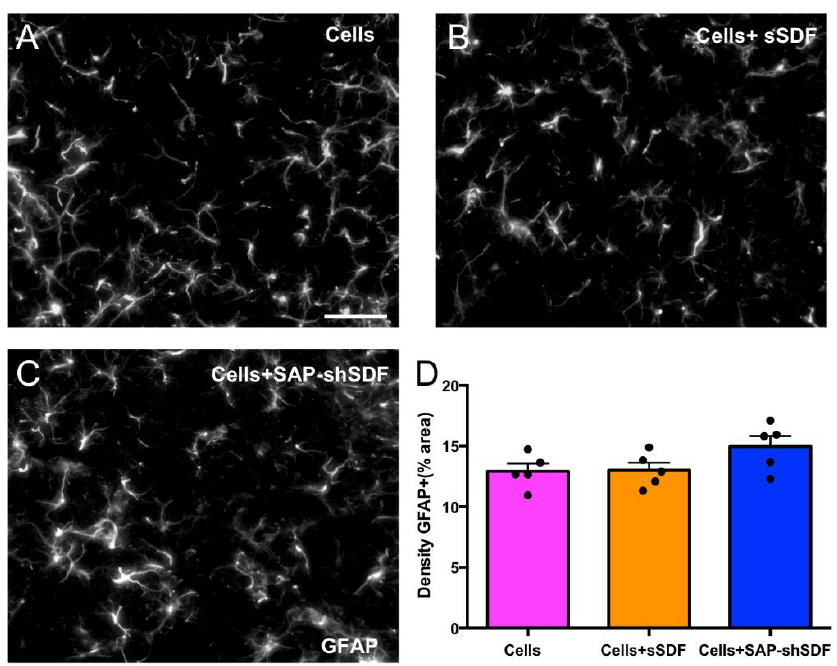
Figure 2. Homeostatic hydrogel has no effect on the host inflammatory response. ( A – C ) Representative images of GFAP+ immunolabeling adjacent to GFP+ graft in Cells, Cells + sSDF, and Cells + SAP-shSDF groups, respectively, scale bar = 50 μ m; ( D ) density of GFAP+ reactive astrocytes surrounding the GFP+ graft. Data represent mean ± standard error of the mean (SEM), p = 0.114.